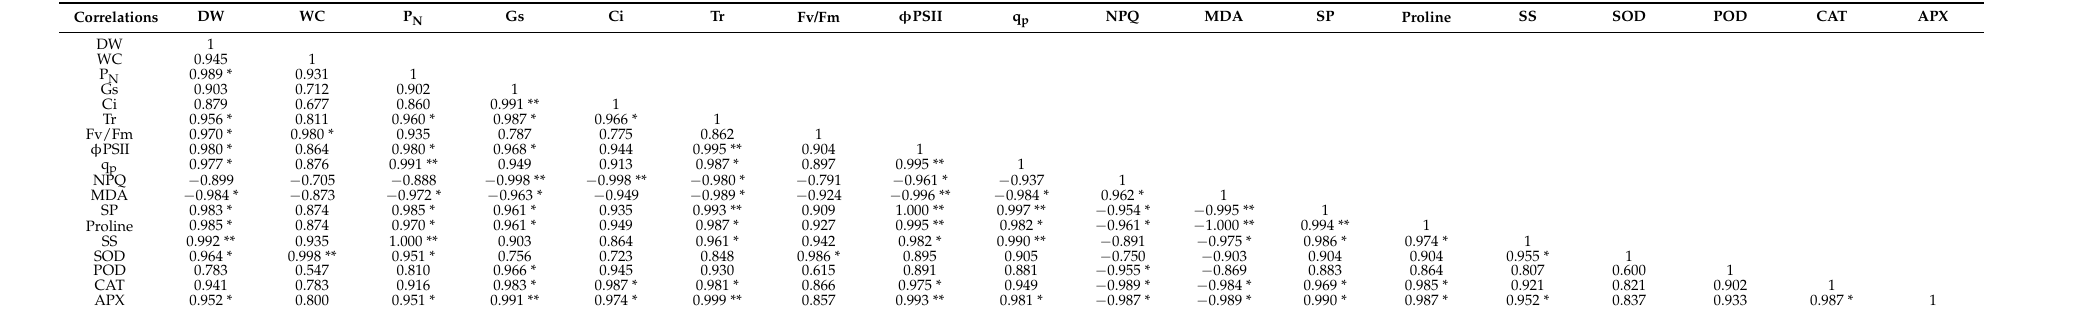
Table A3. Correlation analysis of physiological indexes under drought stress lasting for 10 days